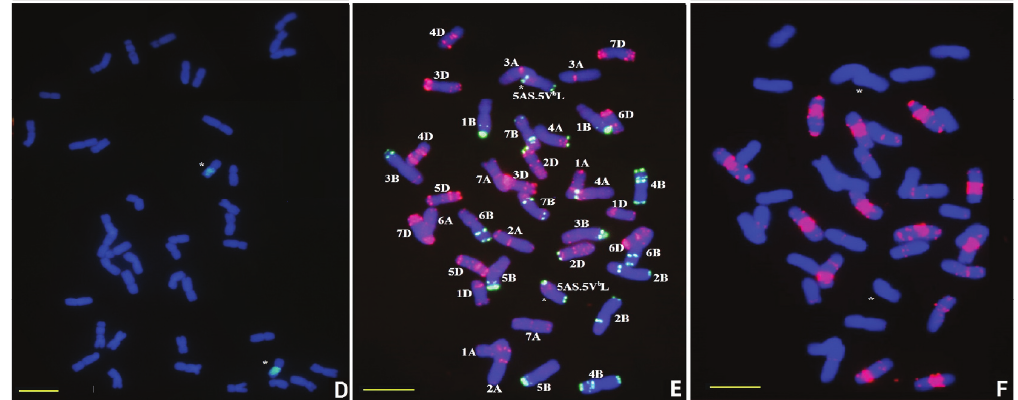
Figure 3. FISH of wheat— D. breviaristatum derivative lines. ( A – C ) wheat-monosomic addition line for chromosome 5V b of D. breviaristatum (D2150) and ( D – F ) 5AS.5V b L translocation line (D2146). The probes pDb12H ( A , D ) and Oligo-pSc119.2 ( B , E ) are showed in green. The probes Oligo-pTa535 ( B , E ) and Oligo- (GAA) 7 ( C , F ) are showed in red. Arrows and stars show the D. breviaristatum chromatin, and bars indicate 10 μm.